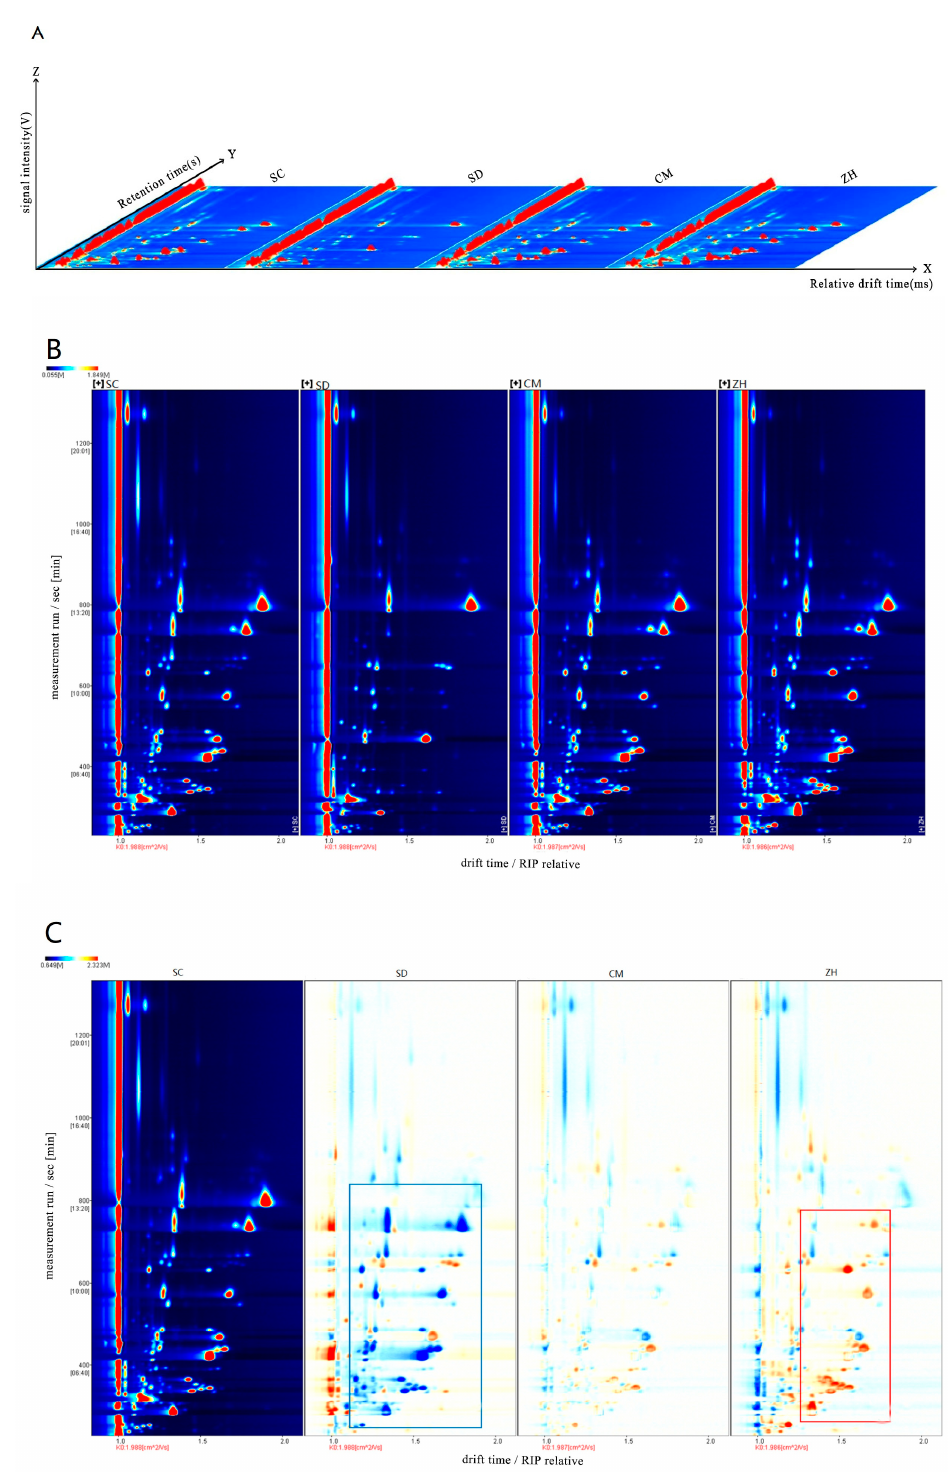
Figure 1. GC-IMS analysis of four different Cui Guan pears. ( A ) 3D-topographic; ( B ) 2D-topographic plots; ( C ) The difference comparison topographic plots.